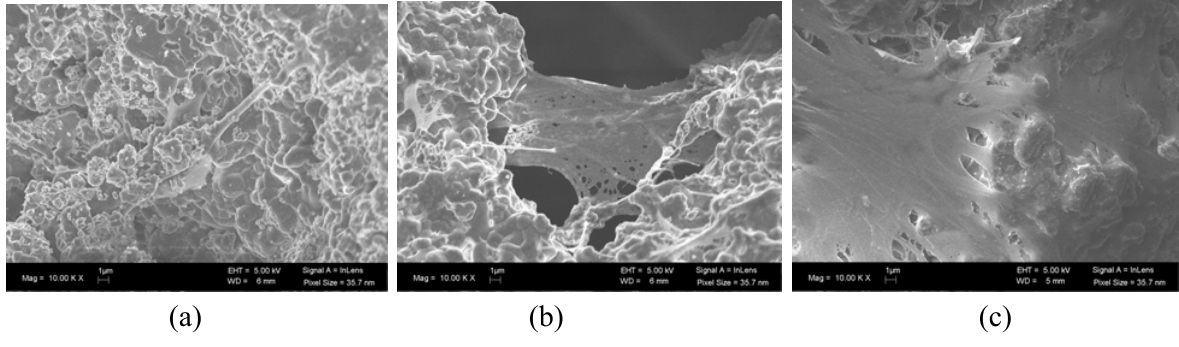
Figure 3. SEM images of the adhesion and proliferation of human mesenchymal stem cells seeded onto a nanostructured BCP ceramic (Osteosynt ®), in the granular form corresponding to 40–60 mesh (approx. 250 to 420 μ m). (a) day 1; (b) day 7; (c) day